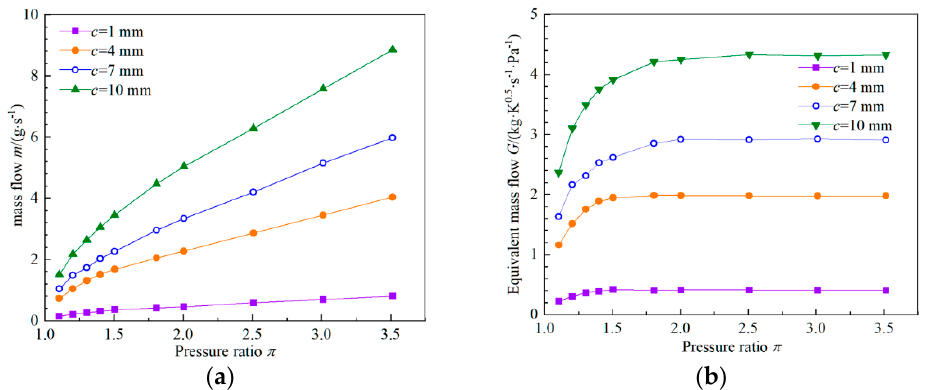
Figure 11. The experimental results curves of clearance leakage and equivalent mass flow of clearance